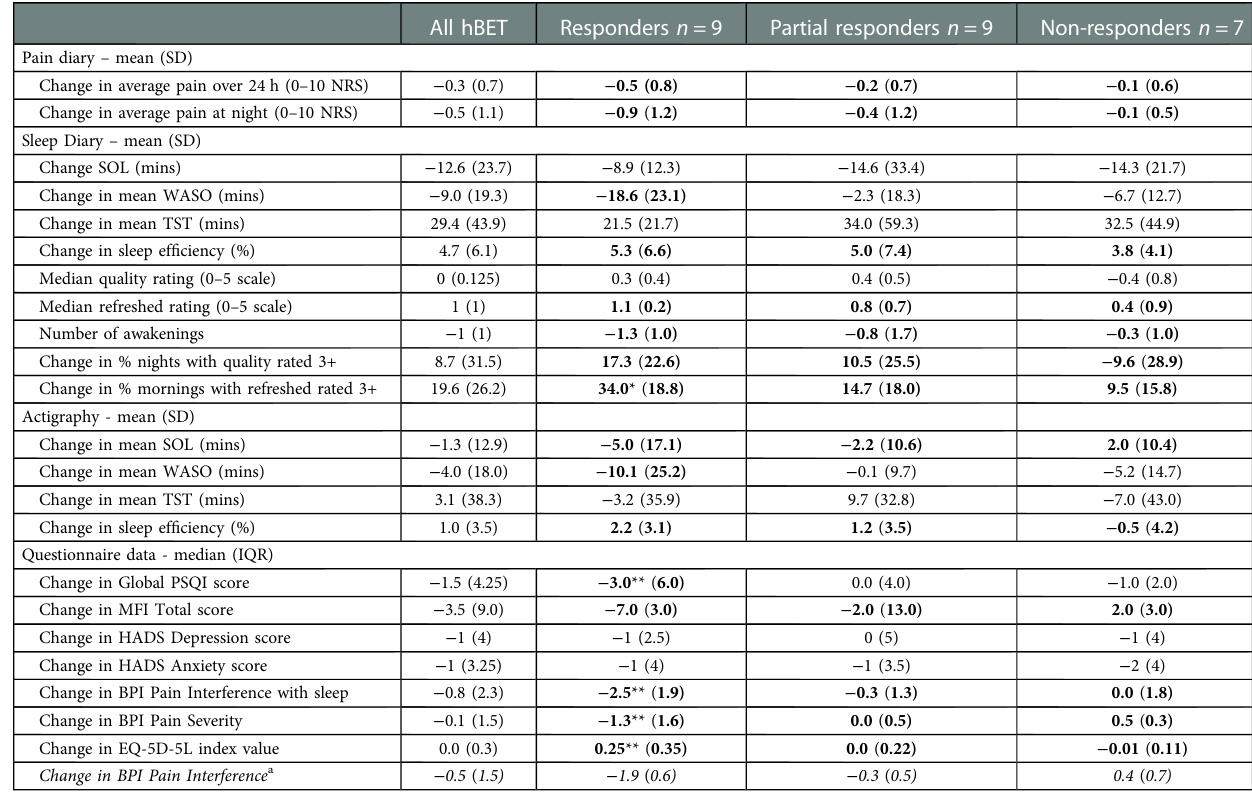
TABLE 5 Responder